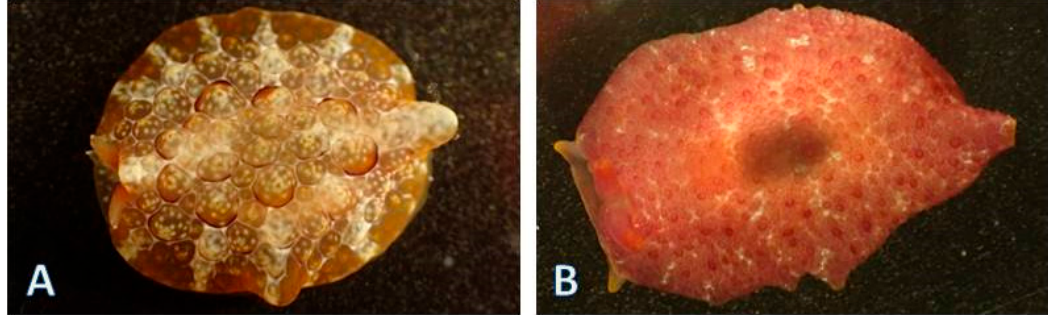
Figure 6. Pleurobranchida: ( A ) Pleurobranchus forskalii, Plfo18Ba-1; ( B ) Pleurobranchus peronii, Plpe18Ba-1.